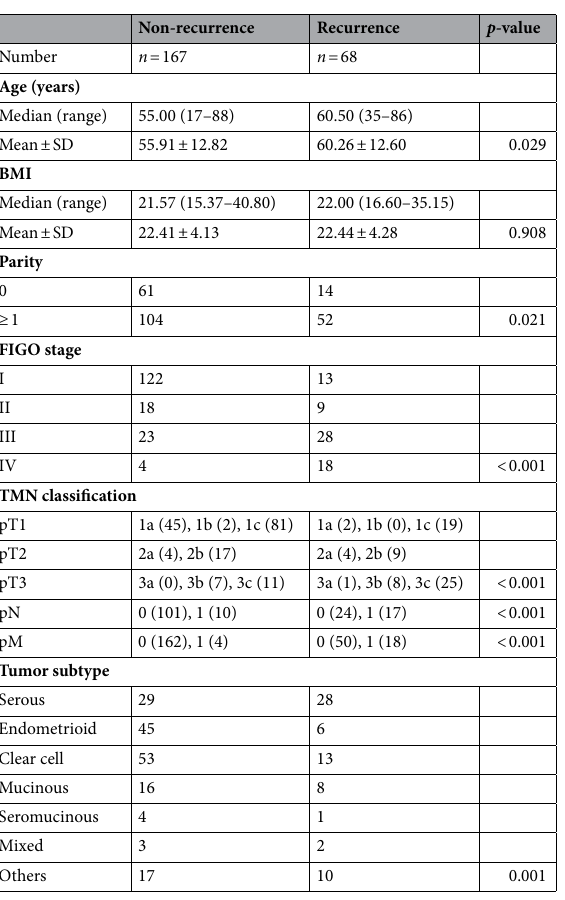
Table 1. Demographic and clinical characteristics of the current cohort. BMI body mass index, FIGO The International Federation of Gynecology and